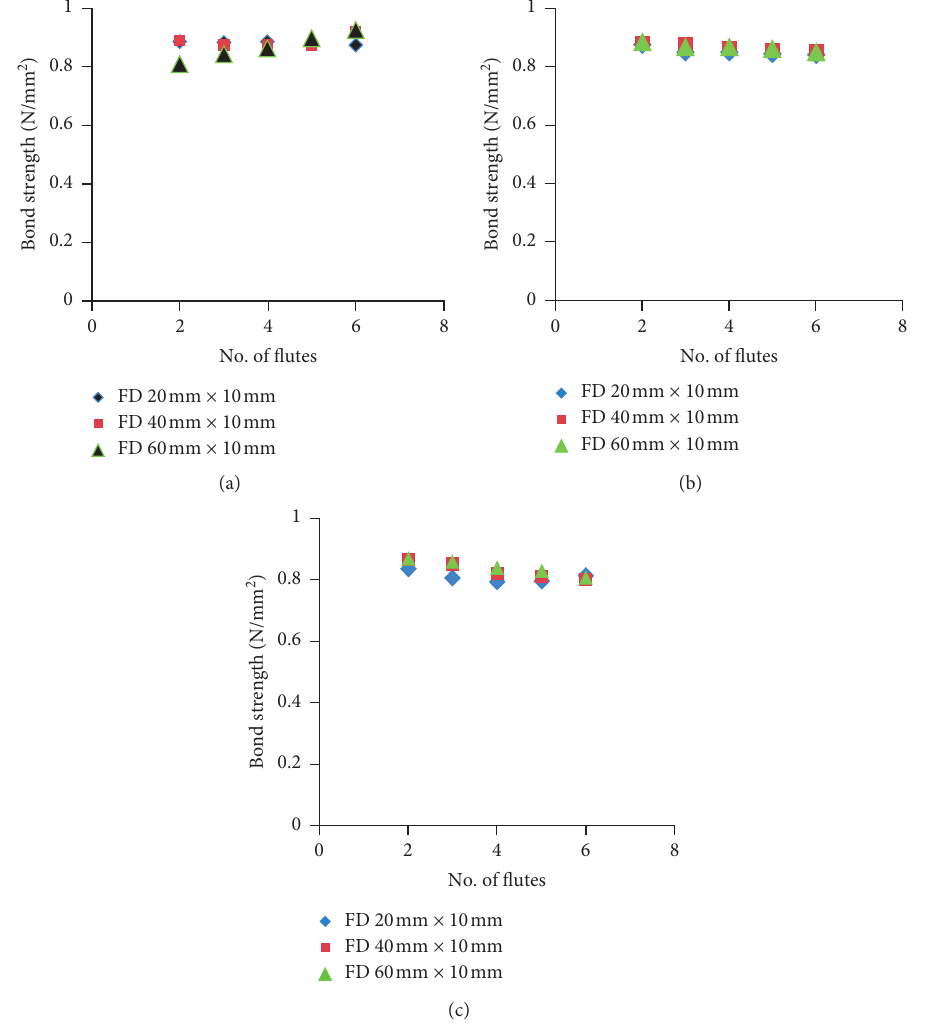
Figure 11: Variation in bond strength with number of flutes: (a) D / t � 40; (b) D / t � 60; (c) D / t � 80.